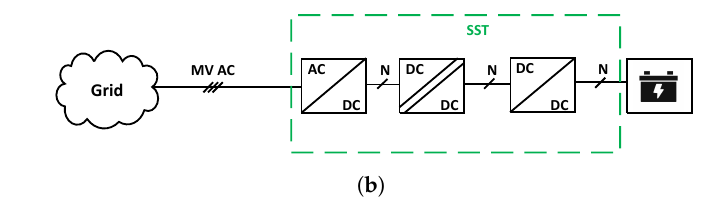
Figure 13. ( a ) Classical approach for utility-scale ESS. Black dots indicate multiple batteries connected in parallel. ( b ) The alternative SST